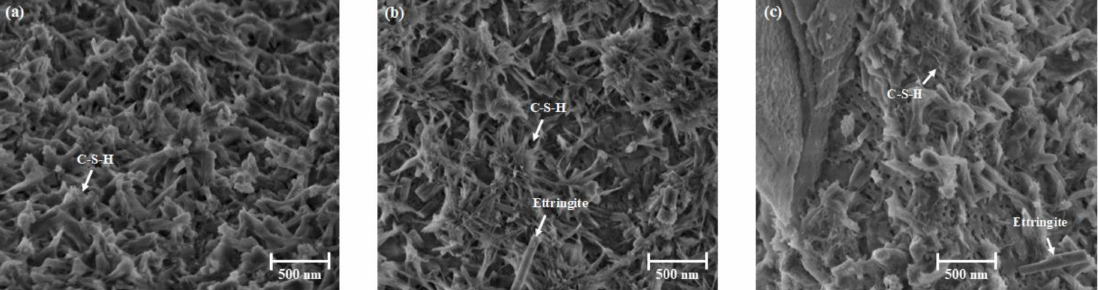
Figure 8. Microstructure of 180 min hydrated cement pastes at 10 ◦ C ( a ), 20 ◦ C ( b ) and 30 ◦ C ( c ) revealed by